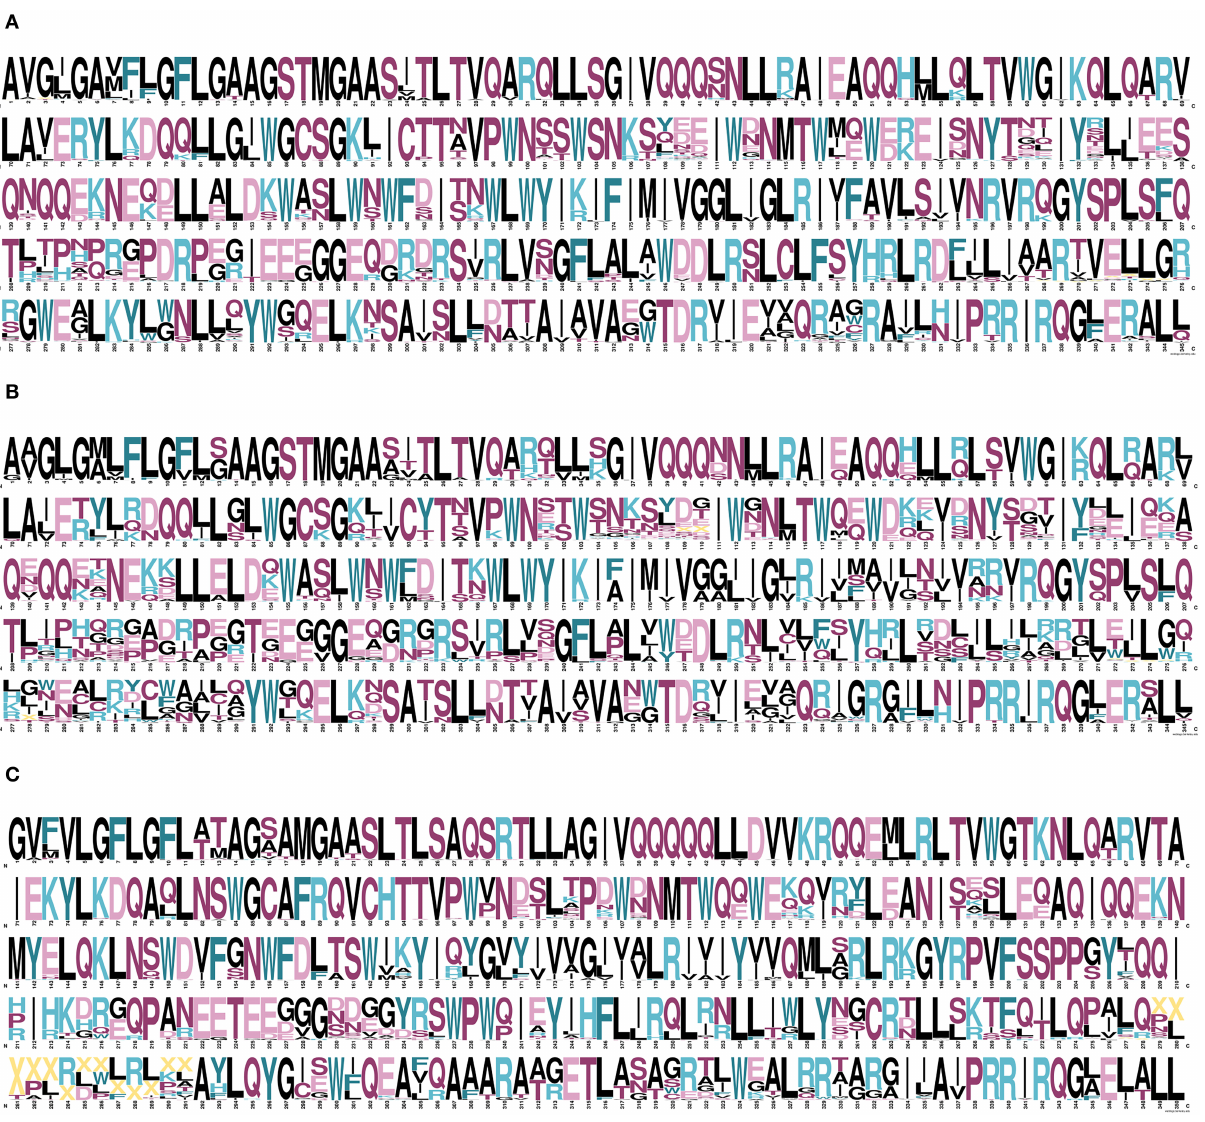
FIGURE 2 | Inferred consensus transmembrane sequences for HIV-1 group M (A) , HIV-1 (B) , and HIV-2 (C) . Each residue includes the most frequent aa present in the corresponding alignment. The aa code letters were represented in proportion to their percentage of conservation. Color code according to their side-chain: non-polar aliphatic (glycine, G; alanine, A; valine, V; leucine, L; methionine, M; isoleucine, I) in black; aromatic (phenylalanine, F; tyrosine, Y; tryptophan, W) in dark blue-green; polar uncharged (serine, S; threonine, T; cysteine, C; proline, P; asparagine, N; glutamine, Q) in fuchsia; positively charged (lysine, K; arginine, R; histidine, H) in light-blue, and negatively charged (aspartic acid, D; glutamic acid, E) in light-pink. Deletions were represented by “X” in